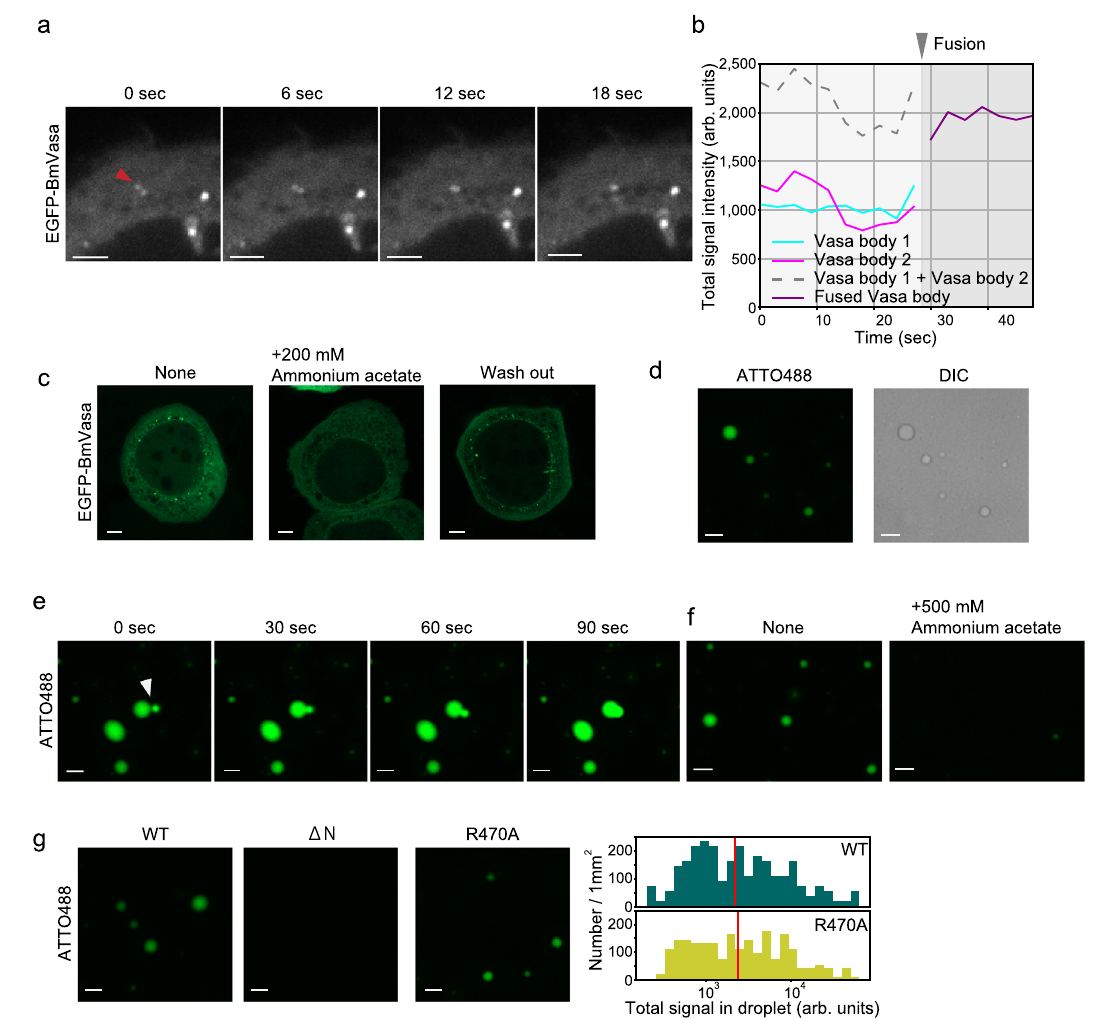
Fig. 2 | Recombinant BmVasa has the ability to assemble nuage-like droplets in vitro. a Snapshots of live imaging of EGFP-BmVasa in BmN4 cells. Two cyto- plasmic EGFP-BmVasa-positive droplets indicated by a red triangle merge over time. Scale bar: 2 μ m. b Signal intensity of Vasa body before and after fusion was quanti fi ed. c EGFP-BmVasa-positive droplets in BmN4 cells (None) disappeared upon treatment with 200mM ammonium acetate. After washing out the salt, BmVasa-positive droplets were re-formed. Scale bar: 5 μ m. d In vitro droplet for- mation assays in the presence of 15% PEG 6000 showed that 1.5 μ M ATTO488- labeled recombinant BmVasa has activity to assemble nuage-like droplets. DIC: